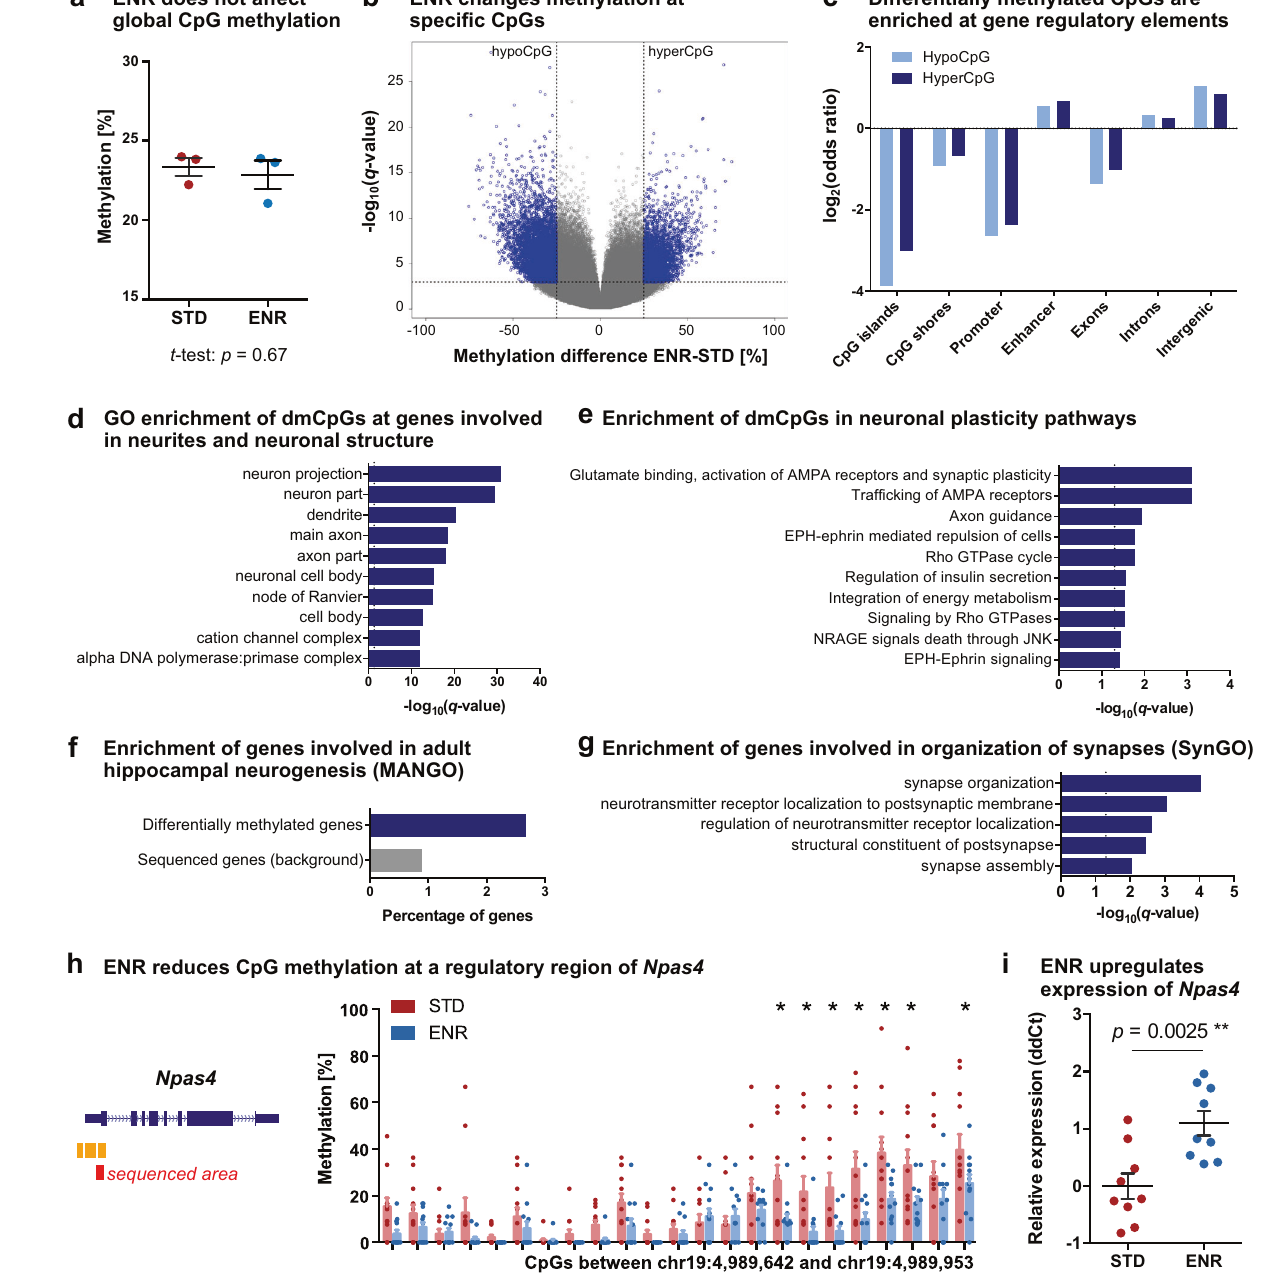
neuronal signaling, and energy metabolism (Supplementary Fig. 3e; Supplementary Data 4). Remarkably, enriched pathways of genes with age-related DNA methylation changes overlapped signi fi cantly with enriched pathways of ENR-induced differen- tially methylated genes in the non-aged brain (hypergeometric test: p = 2.1 × 10 − 12 ), which suggested that aging and ENR changed DNA methylation at genes involved in similar pathways. ENR counteracts age-related DNA methylation changes . To investigate the effect of life-long ENR on aging, we fi rst compared global aging-induced DNA methylation changes between STD and ENR mice. In STD mice, aging was associated with a global 13.81% decrease in CpG methylation (Fig. 2a), which is in accordance with the predominant CpG hypomethylation found